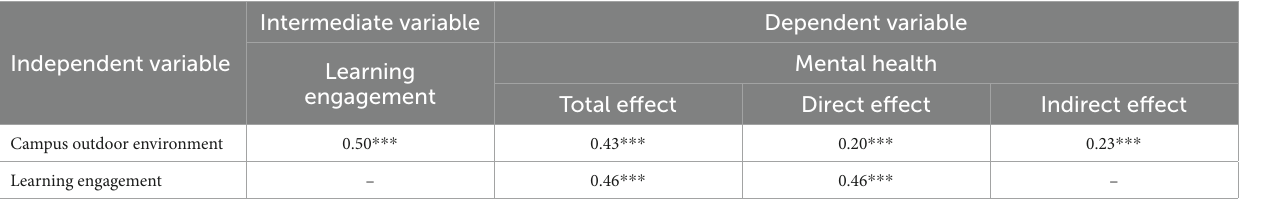
Table 8 and Figure 2 compared the model fitting results based on samples of different grades of college students. The data of